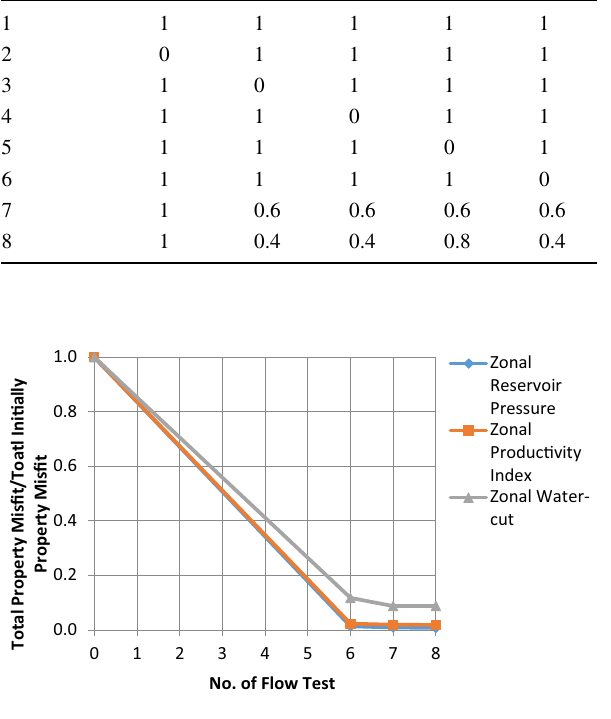
Table 2 ICV configuration in multi-rate flow tests Flow test no.